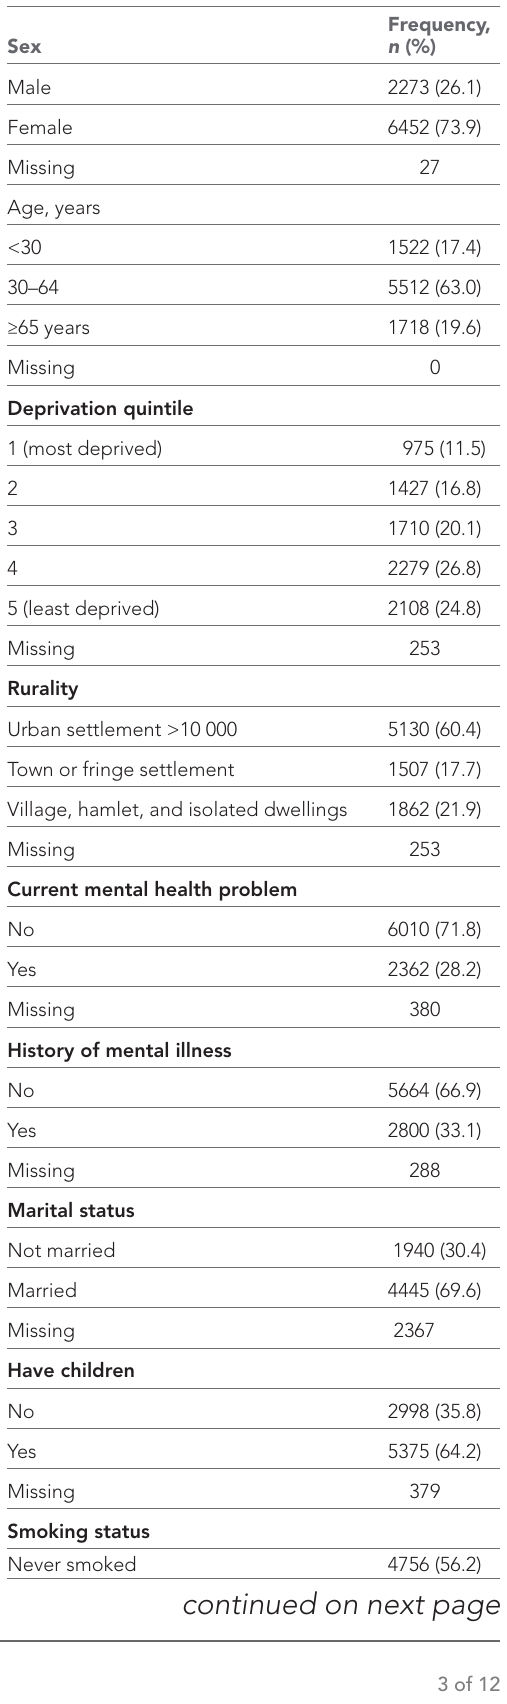
Table 1 Study participant characteristics ( n